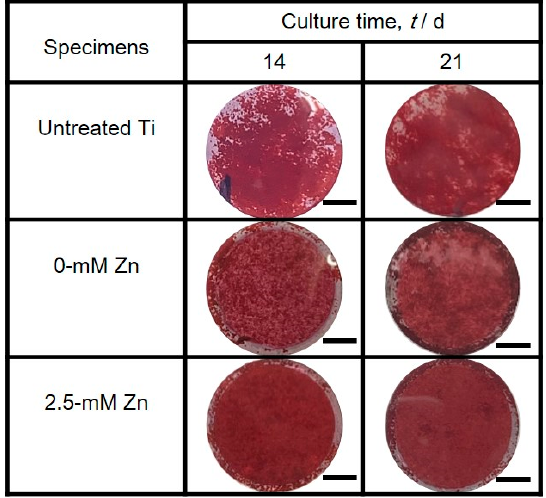
Figure 9. Color scale stained by alizarin red S of calcified deposits by MC3T3-E1 cells on each specimen cultured for 14 and 28 days. Scale bar represents 2 mm.